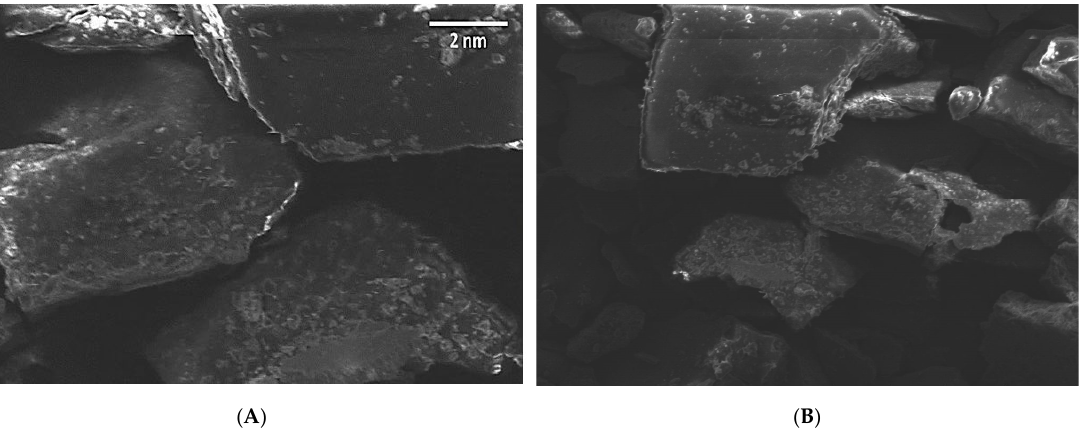
Figure 4 . Scanning electron micrograph of ZVI - NPs synthesized by seed extract of Nigella sativa at Figure 4. Scanning electron micrograph of ZVI-NPs synthesized by seed extract of Nigella sativa at concentration of 25 mM of FeCl 3 . ( A ). at 1000X ( B ). at 500X. concentration of 25 mM of FeCl 3 . ( A ). at 1000 × ( B ). at 500 ×